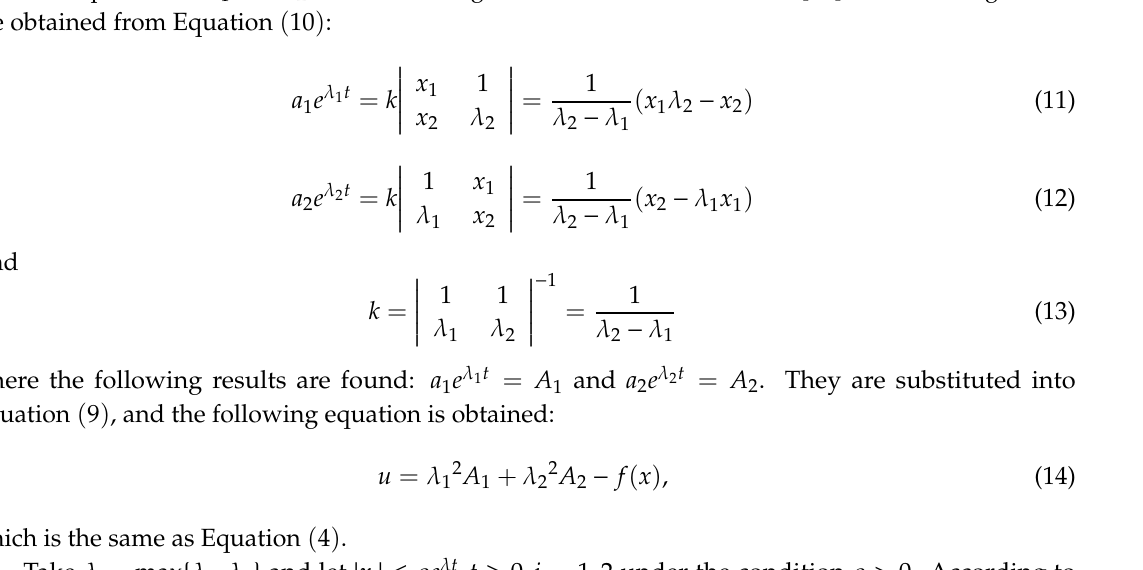
Figure 5. Time response of system with known parameters (without disturbance, λ 1 = − 1, λ 2 = −